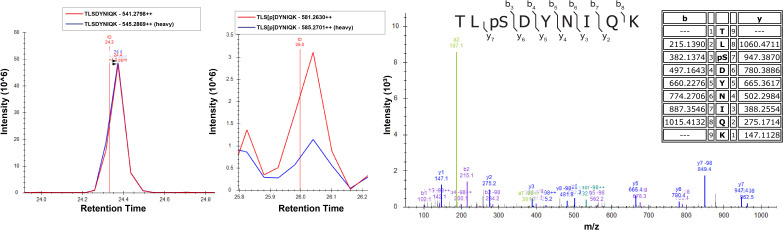
Overexpression of Sks1 in yeast cells increases Ser57 phosphorylation of ubiquitin.Cells were grown in SILAC media supplemented with light or heavy lysine and arginine. Chromosomally expressed 3xFLAG-tagged ubiquitin (from the RPS31 and RPL40B loci) was isolated by affinity purification and digested with trypsin. Phosphopeptides were enriched by immobilized metal affinity chromatography (IMAC), separated by a capillary reverse-phase analytical column, and analyzed on a Q Exactive mass spectrometer. Theoretical masses of b/y ions are tabulated and MS-observed masses are shown in the spectra.